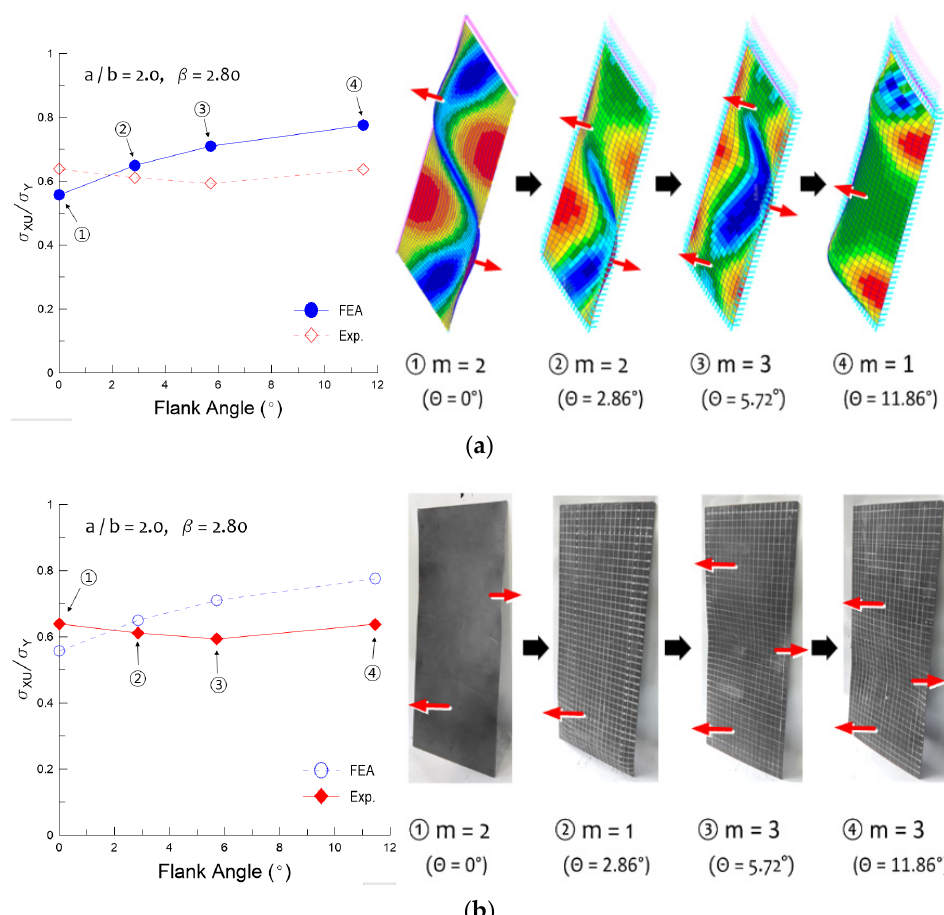
Figure 11. The buckling shapes of curved plates depending on the flank angle: ( a ) FE analysis and ( b ) experiment results.